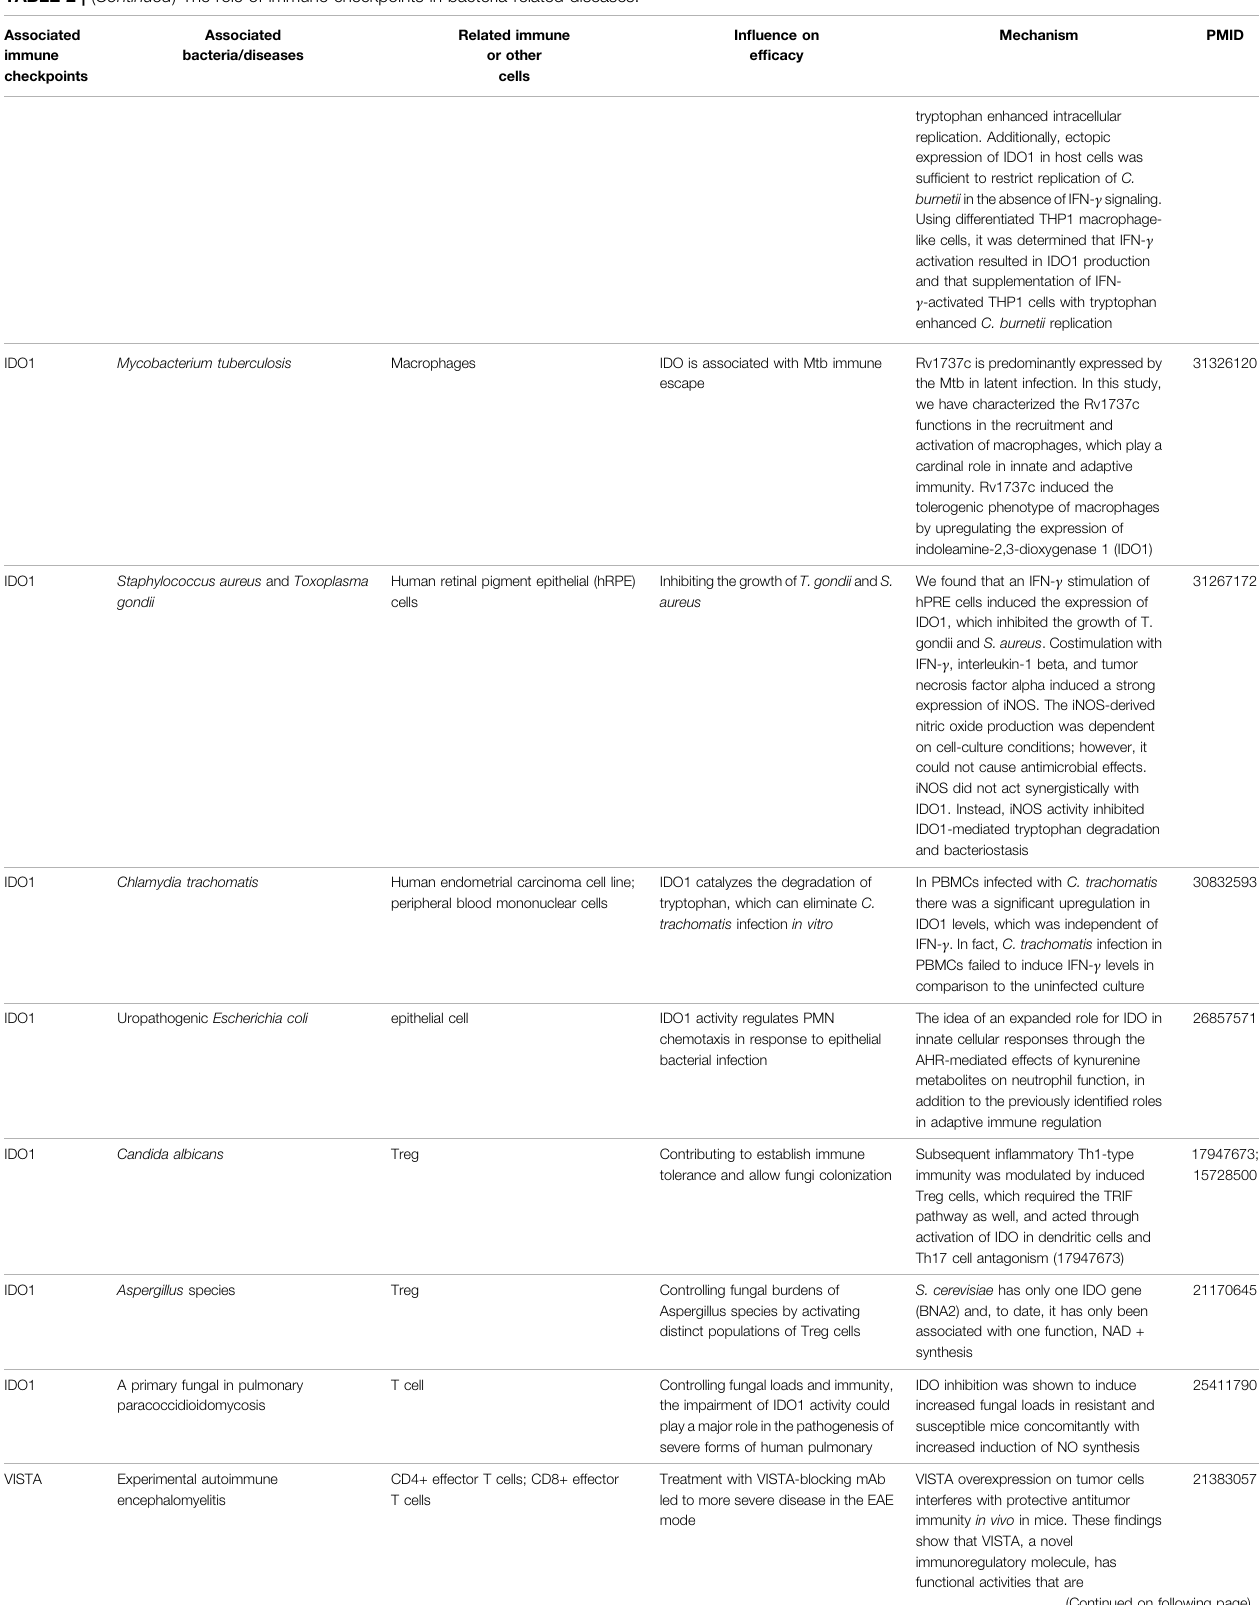
TABLE 2 | ( Continued ) The role of immune checkpoints in bacteria-related